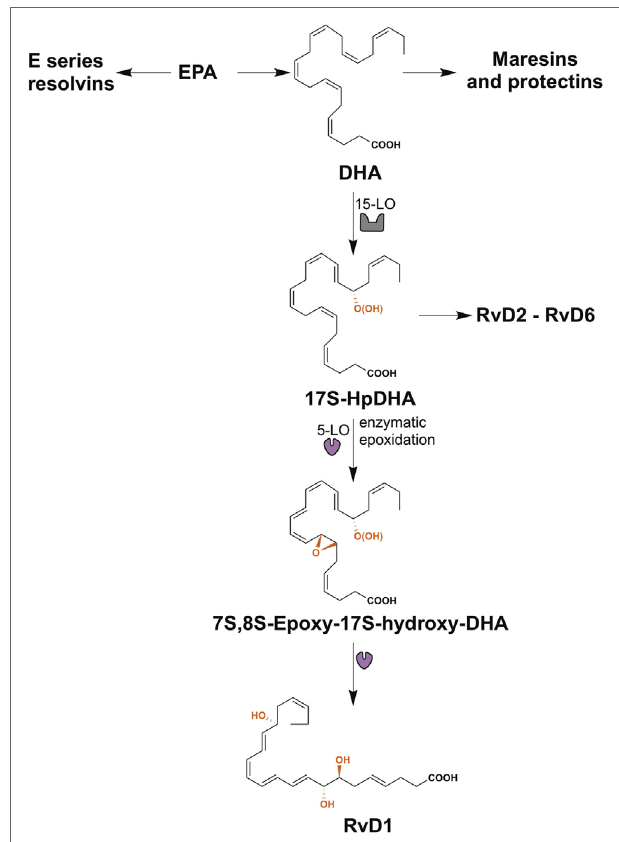
FigURe 2 | The biosynthesis of resolvin D1 (RvD1). The resolvins from the E-series (resolvins E1–E3) are synthesized from eicosapentaenoic acid (EPA), while maresins (maresin-1 and maresin-2), protectins (protectin-1 and neuroprotectin-1), and resolvins of the series-D (resolvins D1–D6) are produced from docosahexaenoic acid (DHA). RvD1 is generated from the sequential oxygenation of DHA, a process catalyzed by 15-lipoxygenase (15-LO) and 5-lipoxygenase (5-LO). The initial conversion of DHA to 17S-HpDHA is catalyzed by 15-LO, followed a second lipoxygenation via 5-LO, which gives a peroxide intermediate that is transformed to 7 S -,8 S - epoxid-17 S -hydroxy-DHA. Subsequently, the enzymatic hydrolysis of this compound generates the trihydroxylated product